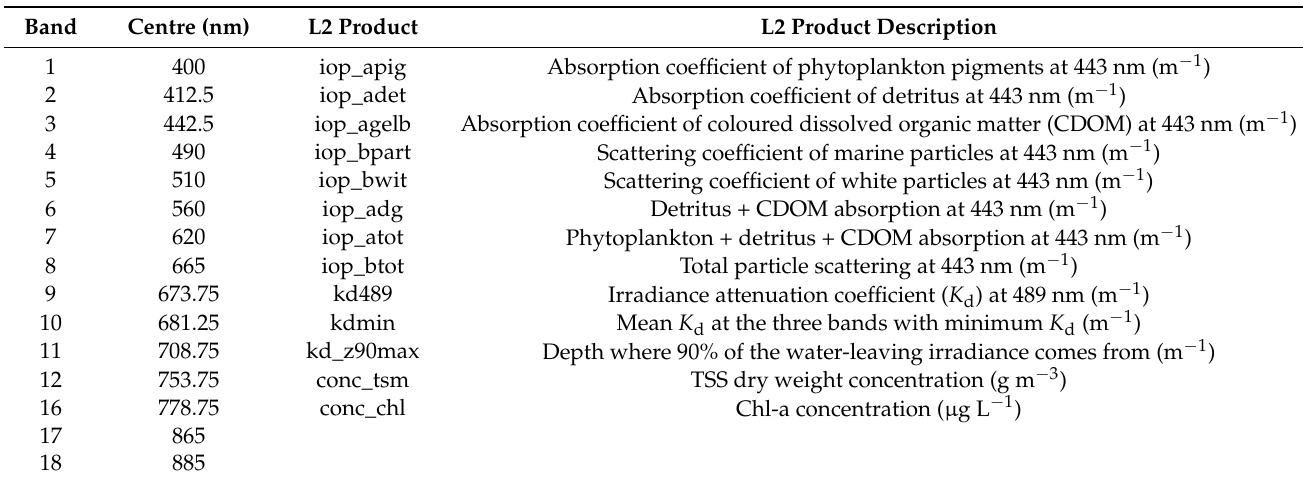
Table 3. Sentinel-3 OLCI spectral bands, their central wavelengths for Case 2 Regional